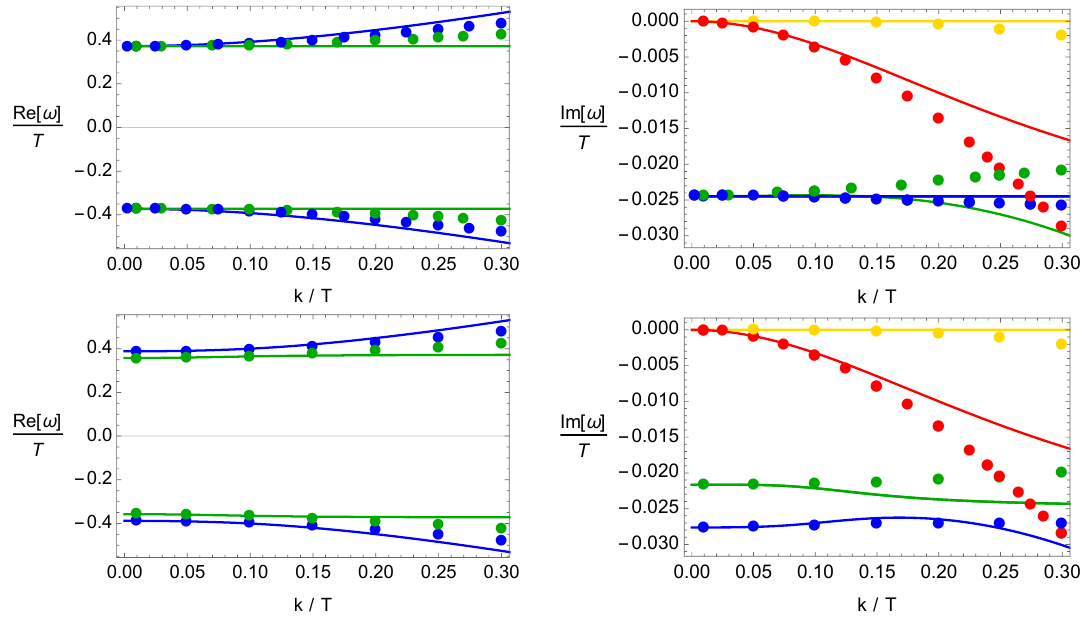
Figure 4 . Lowest QNMs at finite density ( µ/T = 5 ). Top and bottom panels refer respectively to B/T 2 = 0 , 0 . 5